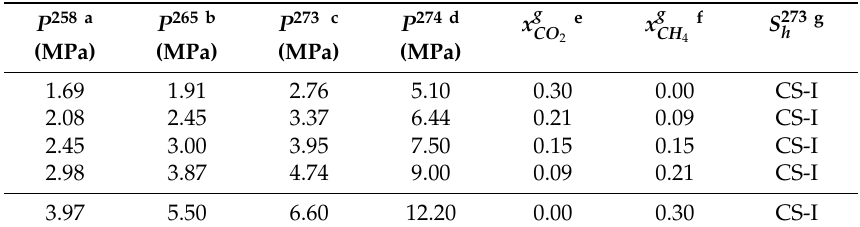
Table 2. P - T - x equilibria for CO 2 + CH 4 + N 2 +H 2 O in gas–hydrate–ice (water) systems at 70% N 2 in the gas phase.